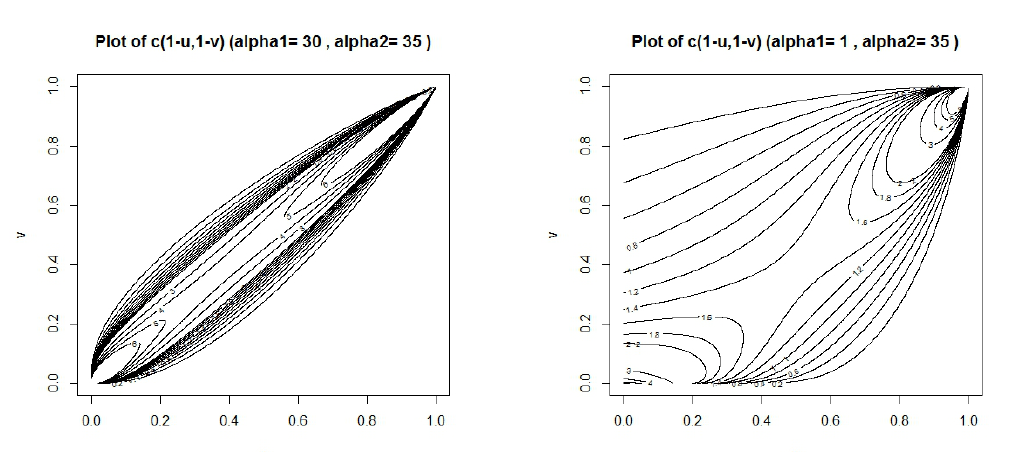
Figure 3.2: Plots of (cid:98) c ( u , v ) = c (1 − u , 1 − v ) for different α 1 and α 2